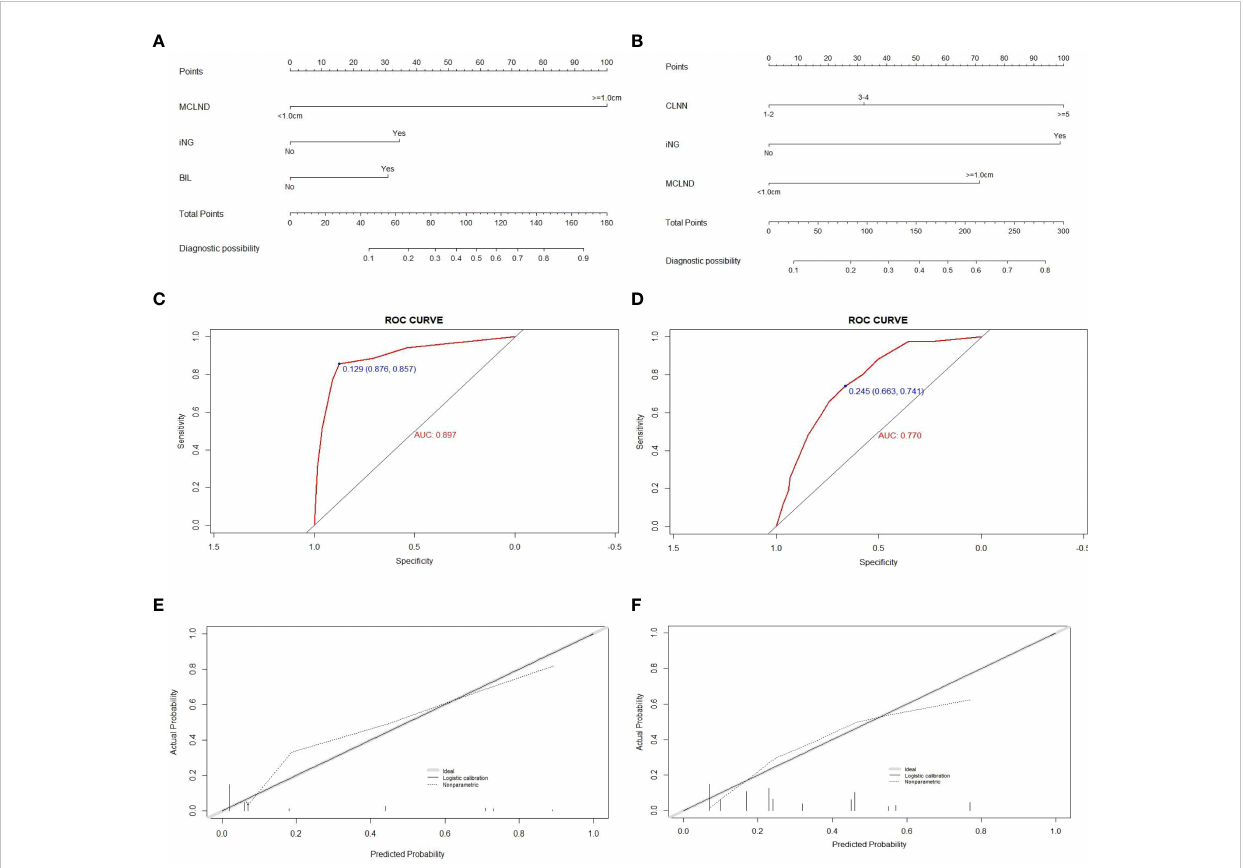
FIGURE 3 Construction, assessment, and validation of the predictive model of LLNM. (A, B) The nomograms for predicting LLNM risk in patients within no-TCI and TCI groups, respectively; (C, D) The ROC curve and AUC of the nomograms for predicting LLNM risk in patients within no-TCI and TCI groups, respectively; (E, F) The calibration curves of the nomogram for predicting LLNM risk in patients within no-TCI and TCI groups, respectively. Actual probability is plotted on the y-axis, and nomogram predicted probability on the x-axis. LLNM, lateral lymph node metastases; TCI, thyroid capsular invasion; ROC, receiver operating